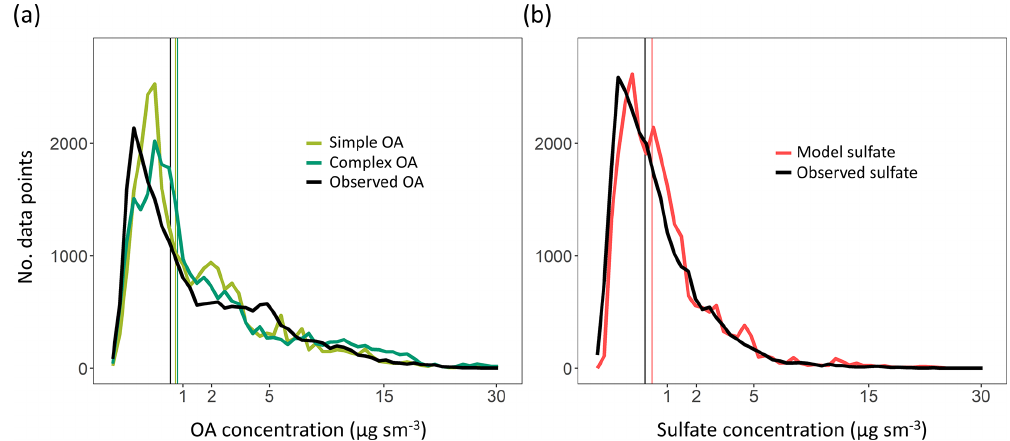
Figure 6. (a) Distribution plots of OA mass concentrations for the complex scheme (dark green), simple scheme (light green) and AMS observations (black). The x axis has been transformed using a square-root function. Vertical lines represent median values for the different distributions. (b) Distribution plots of sulfate mass concentrations for the model (red) and AMS observations (black). Refer to Sect. 3 for details on model sampling and